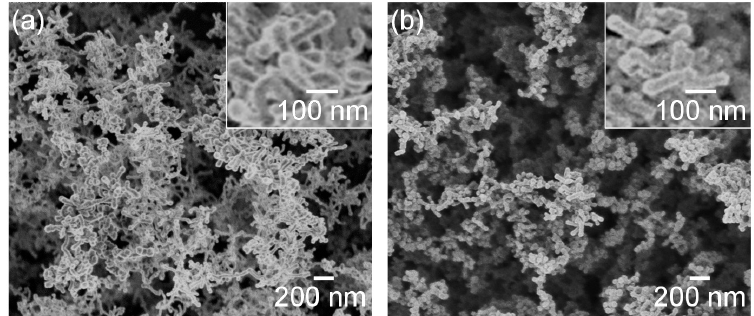
Figure 9. SEM photographs of nanomaterials generated from sludge preheated at ( a ) 400 and ( b ) 900 °C. The inserts are close-up views.